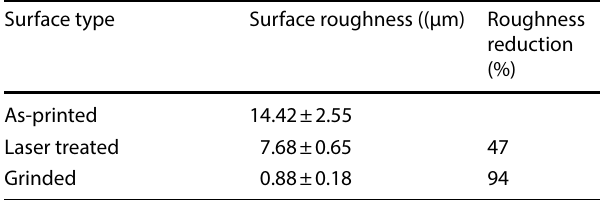
Table 1 Surface roughness of samples with different post treat- ments